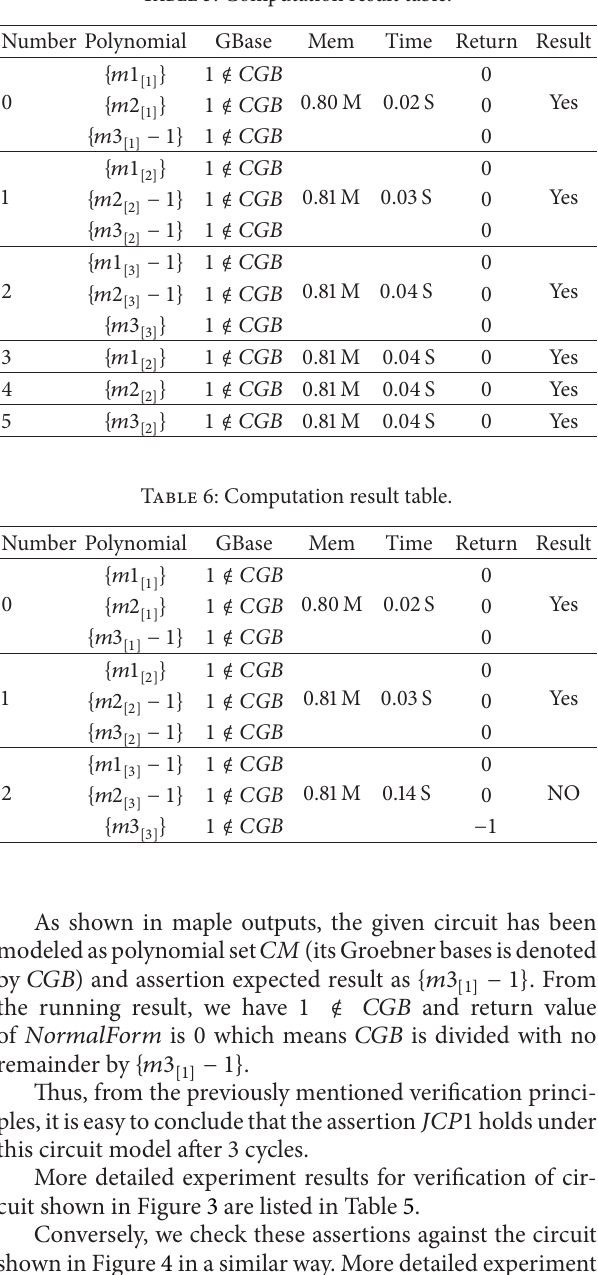
Table 5: Computation result table.